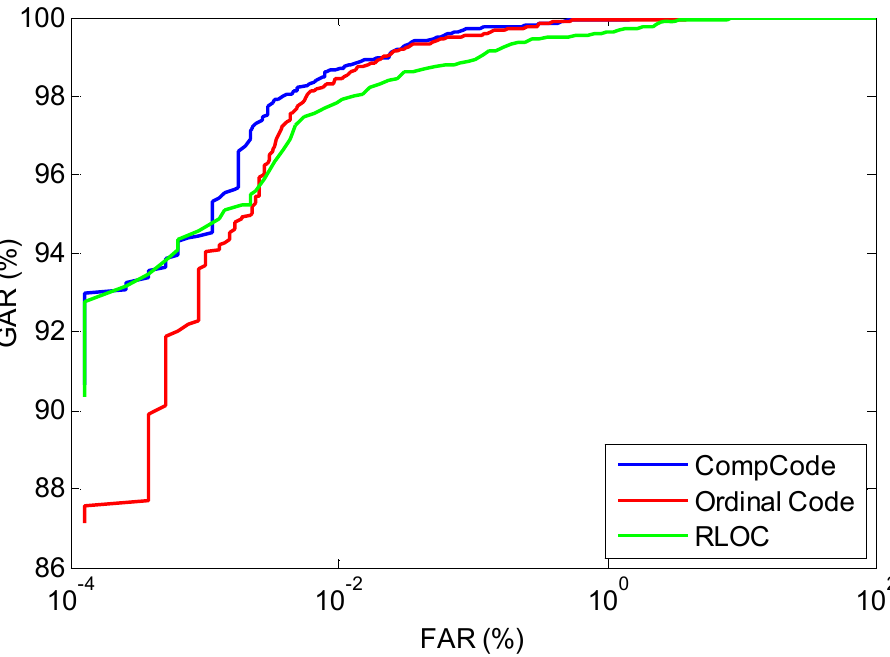
Figure 13. The ROC curves of methods Comp Code, Ordinal Code and RLOC on across-sub-database A_N5800 (using the 1~3 samples of the first session as the training set).